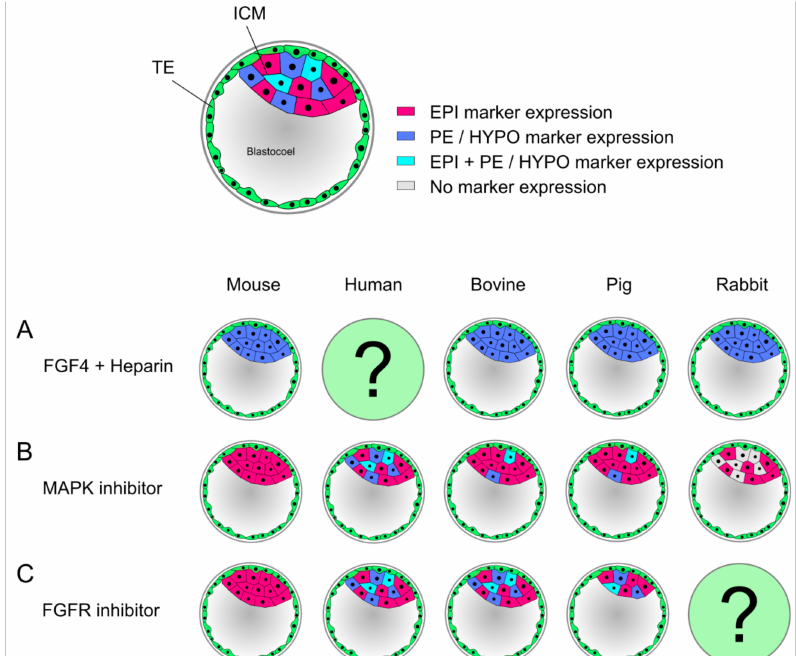
Figure 2. Effects of modulators during second lineage specification vary between mammals. ( A ) Supplementation of FGF4 and heparin leads to a ubiquitous expression of primitive endoderm (PE) and hypoblast (HYPO) markers (dark blue) in mouse and bovine, pig, and rabbit blastocysts, respectively. In human, no experiment has been reported. ( B ) Inhibition of MAPK induces a pan-ICM epiblast (EPI) marker expression (magenta), in sharp contrast to human, where it has no effect. In bovine and pig blastocysts, inhibition of FGF/MAPK pathway does not prevent formation of HYPO precursor cells, though the number of HYPO marker expressing cells is significantly reduced. In bovine, a significant shift towards EPI identity is seen (in pig not significant). Rabbit embryos treated with MAPK inhibitors show no effect on EPI marker expressing cells, but HYPO marker expression was abolished, hence leaving cells with no marker expression (gray), where the identity is unknown. ( C ) Treatment of embryos upstream of MAPK pathway with FGF-receptor inhibitors display a homogenous PE marker expression in mouse blastocysts, similar to MAPK inhibition. In human and bovine embryos, FGFR inhibitors have no effect, whereas in pig embryos, a decreased ICM was reported, but showing a normal distribution of EPI and HYPO markers. In rabbit embryos, the effect is still